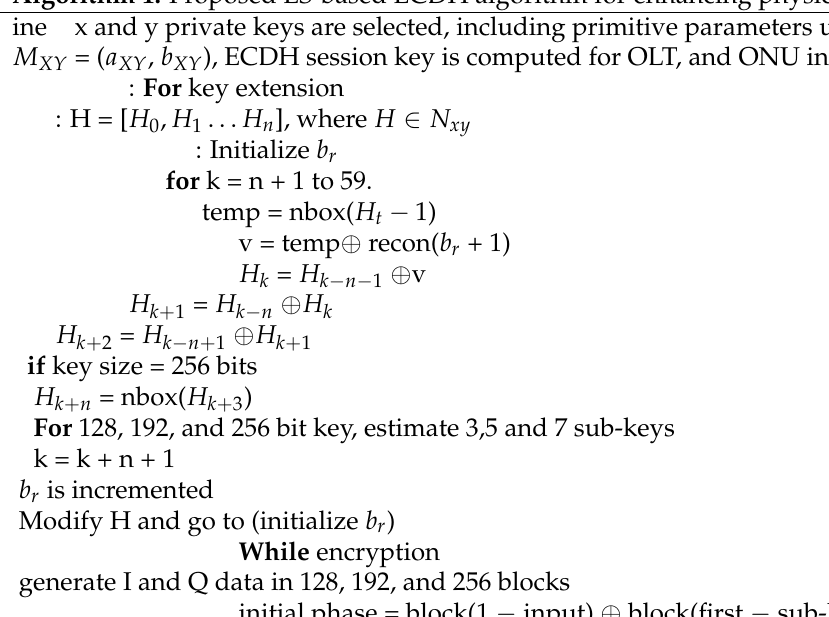
Algorithm 1: Proposed ES-based ECDH algorithm for enhancing physical layer security in ONs ine